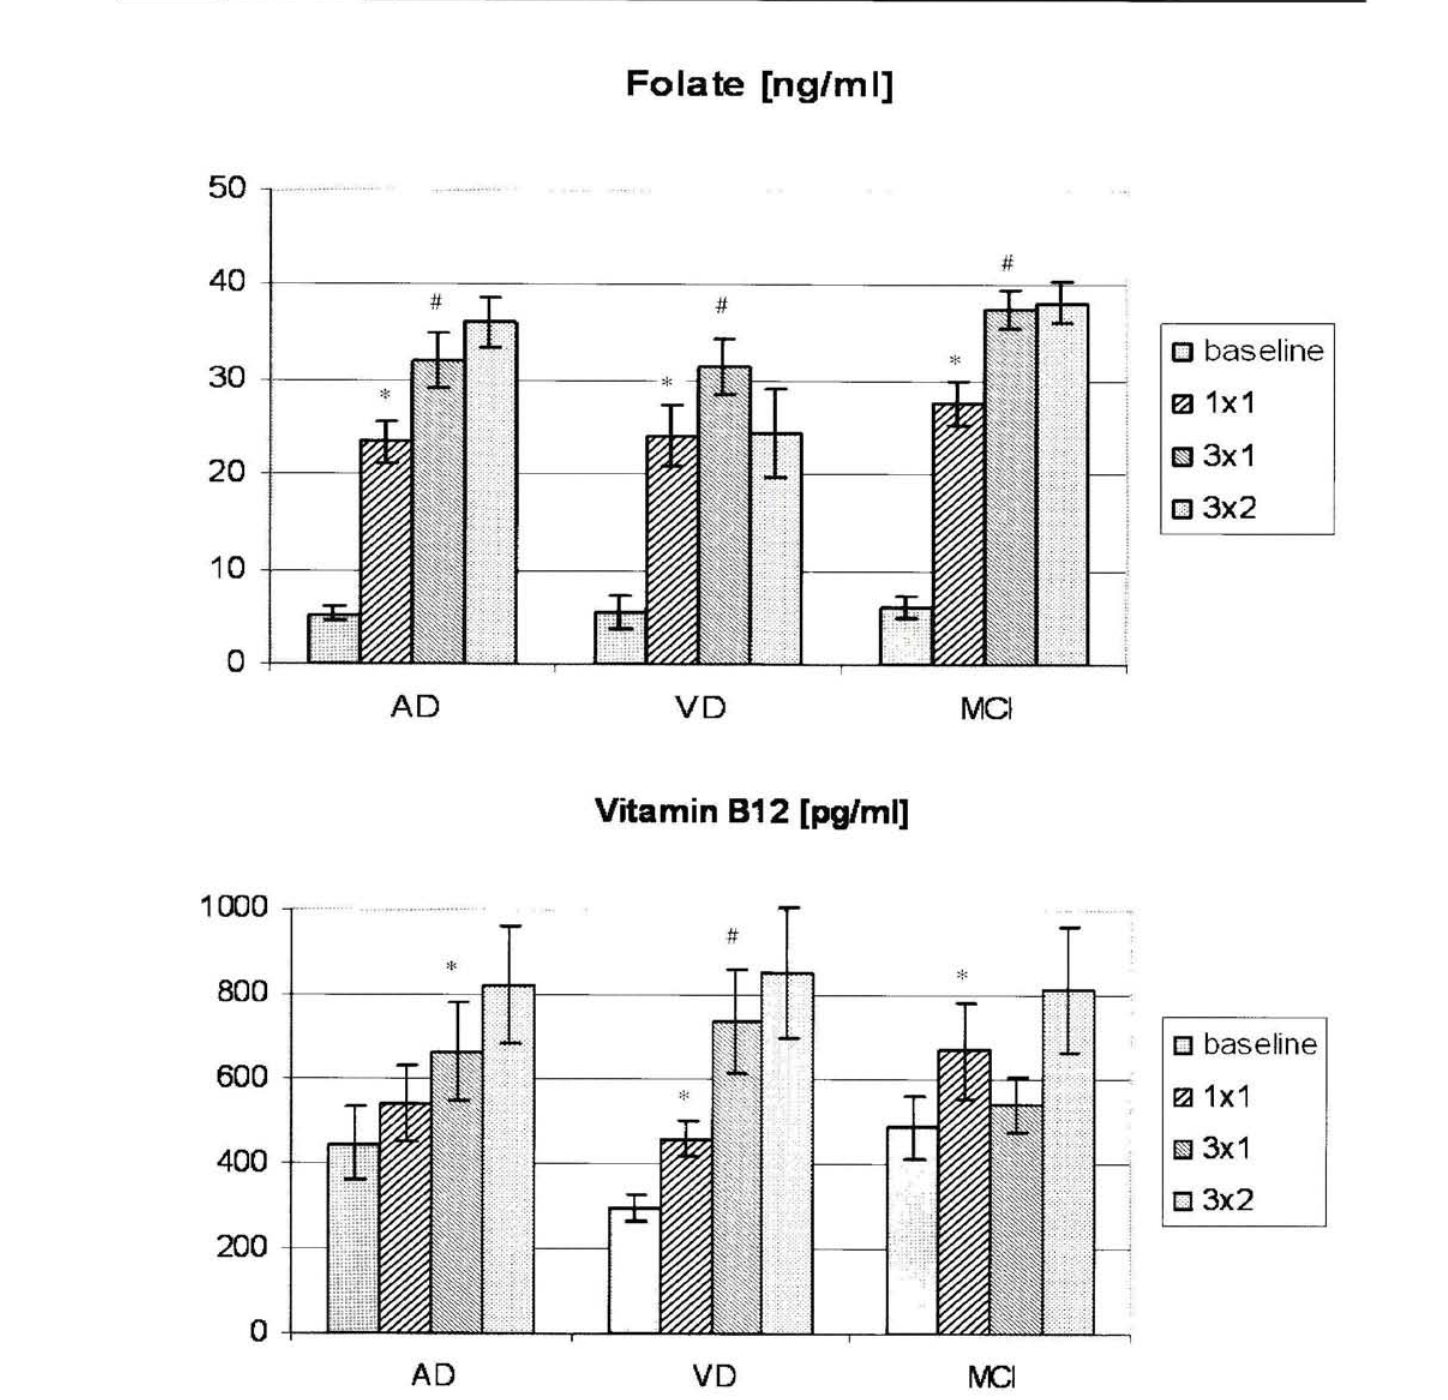
Pteridines/Vol. 1 7/No.